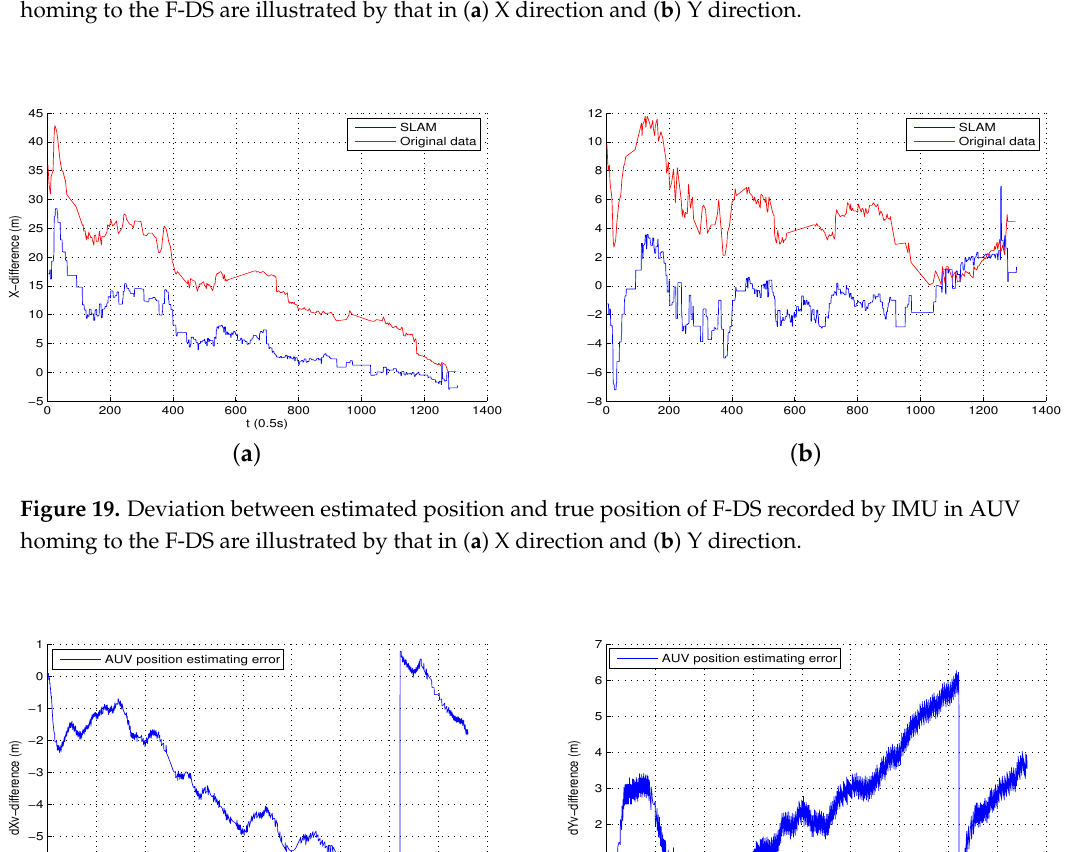
Figure 18. Deviation between estimated position and true position of AUV recorded by IMU in AUV homing to the F-DS are illustrated by that in ( a ) X direction and ( b ) Y direction.